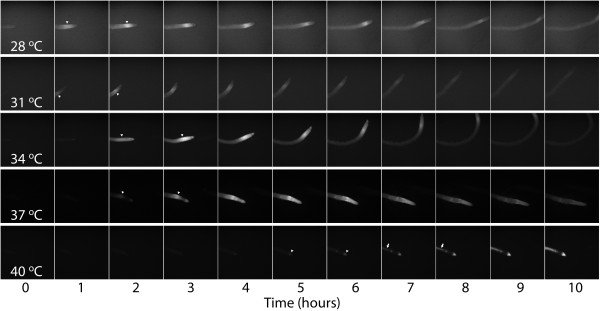
The location ofHsp17.6p:GFP expression maxima is temperature dependent. Hourly images of representative roots heat shocked for an hour at 28-37°C are shown. Arrowheads indicate the location of the brightest signal for the first two time points where the maximum is clear (either the differentiation zone in roots heat shocked from 28-37°C or the root tip in roots heat shocked at 40°C). Arrows indicate late vascular expression in roots heat shocked at 40°C. The contrast of all images in each temperature series was uniformly enhanced using the ImageJ 'enhance contrast’ tool so that both low and high expression patterns can be seen. As a result, intensity should not be compared between temperature series. Quantification of signal intensity can be found in Figure 5.